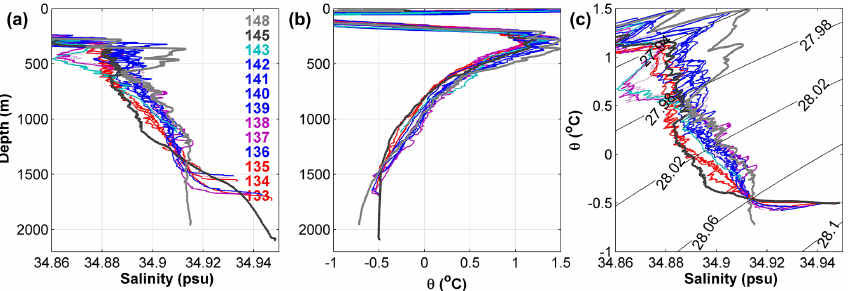
Figure 4. Salinity and potential temperature ( θ ) profiles in the southern passage. The bold profiles show reference stations in the Makarov Basin (station 145; black) and Amundsen Basin (station 148; gray). Blue, magenta and cyan profiles are those at the southern part of the section and the three northernmost are red. For positions of the stations, please refer to Figs. 1 and 2. centrations at depth in the northern part of the section